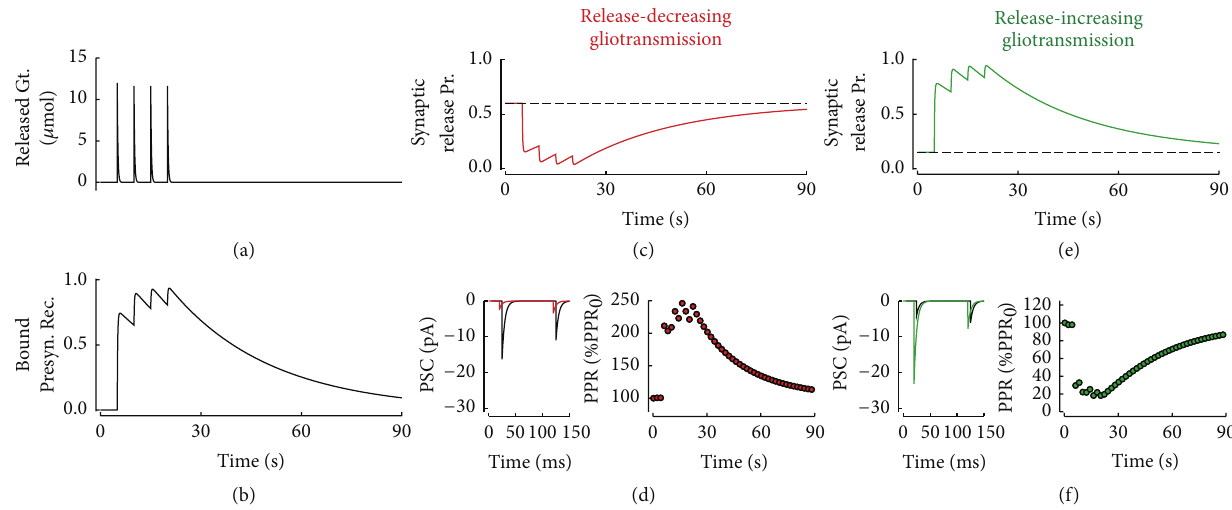
Figure3:Presynapticpathwayofgliotransmission.Gliotransmitterreleasedfromtheastrocyte(a)bindsextrasynapticallylocatedpresynaptic receptors(b)therebydecreasingorincreasingsynapticreleasedependingonthetypeofgliotransmitterandreceptor.Intherelease-decreasing case, synaptic release probability could approach zero by gliotransmission ((c), red trace , 𝜉 = 0 ), although, in practice, less dramatic reductions are more likely to be measured with respect to the original value in the absence of gliotransmission ( black dashed line ). The reduction in synaptic release probability changes pair pulse plasticity increasing the pair pulse ratio (d). In the case of release-increasing gliotransmission, synaptic release probability could instead increase up to one ((e), green trace , 𝜉 = 1 ). In turn, pair pulse plasticity changes towards a decrease of the ensuing pair pulse ratio (f). Parameters as in Table 1 except for 󰜚 𝑒 = 10 −4 , 𝑂 𝑃 = 0.6 𝜇 M −1 s −1 , 𝜏 𝑃 = 30 s, 𝜁 = 0.54 , 𝐽 𝑆 = 3 mV, and = 60 M Ω 𝑅 in